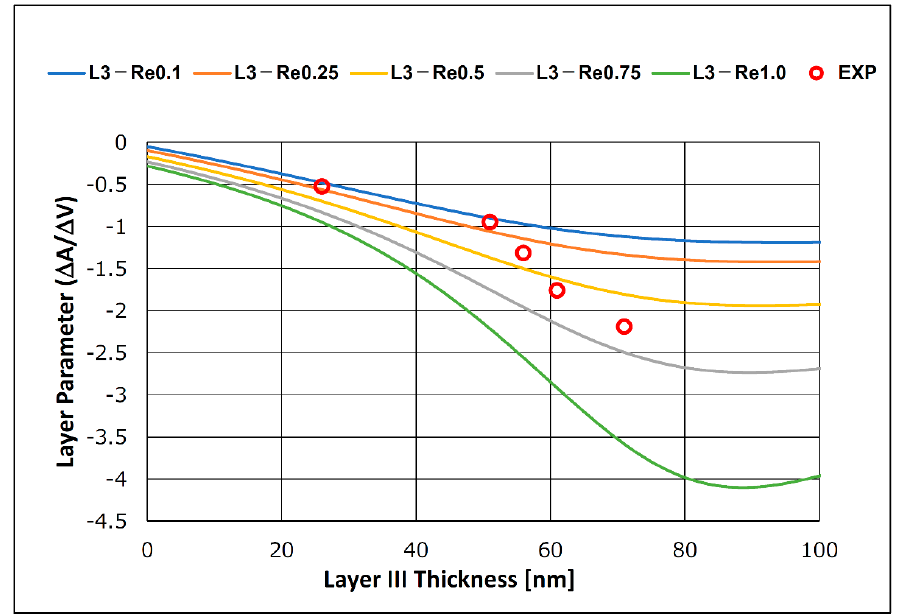
Figure 15. Calculated layer parameter and experimental results.